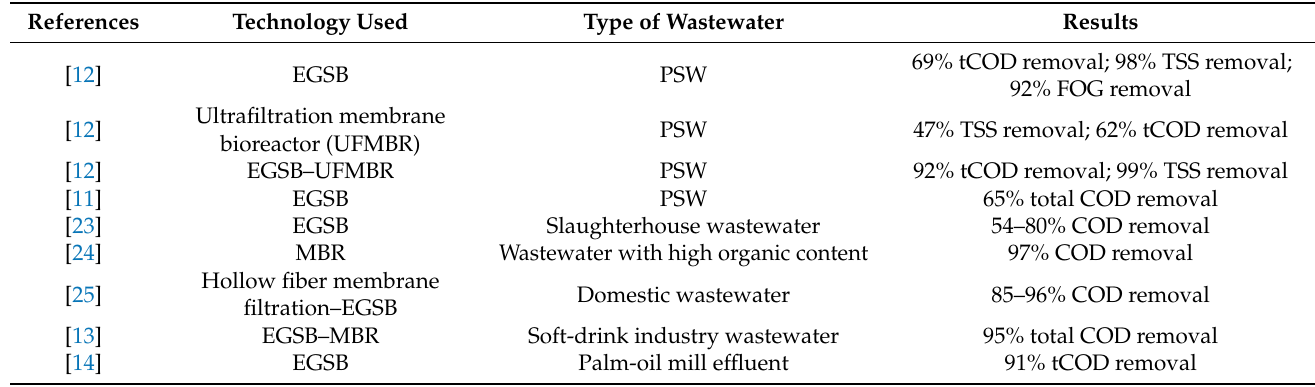
Table 2. Performance reached in similar wastewater treatment